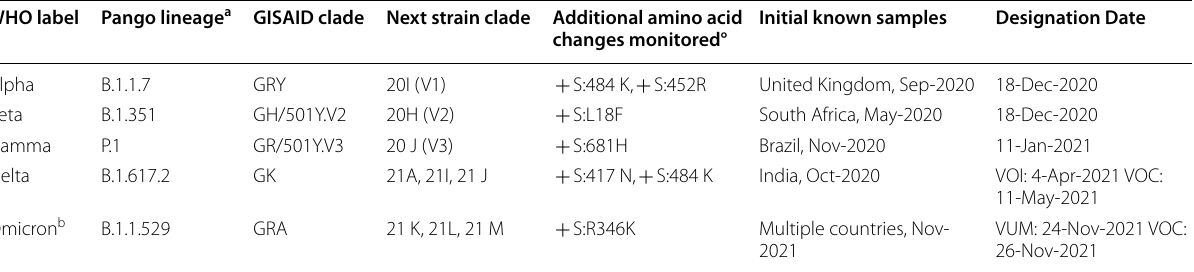
Only found in a subset of